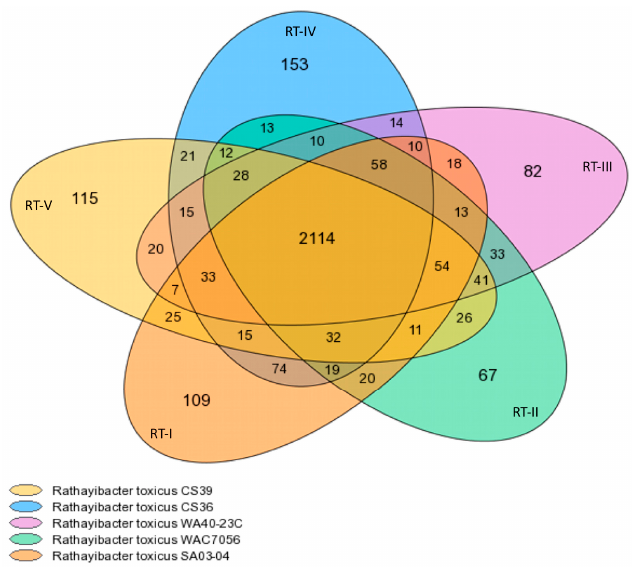
Figure 1. Core- / pan-genome for strains representing R. toxicus populations RT-I, RT-II, RT-III, RT-IV and RT-V. The MicroScope Microbial Genome Annotation and Analysis Platform was used to determine and compare the core- / pan-genome of R. toxicus populations. The numbers represent gene families, as designated by MicroScope. The center of the diagram represents the core-genome. The overlapping regions comprise the variable-genome and illustrate shared gene families among populations. The outer non-overlapping regions represent strain-(population-), specific gene